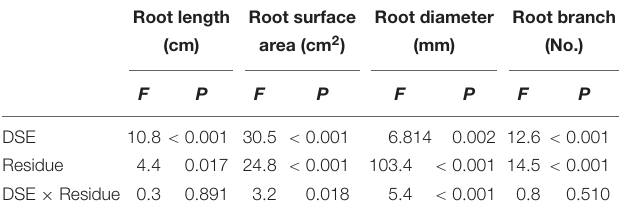
TABLE 1 | Analysis of variance (ANOVA) for the effects of dark septate endophyte (DSE) inoculation and residue treatment (Residue) on the root morphological traits of liquorice plants.